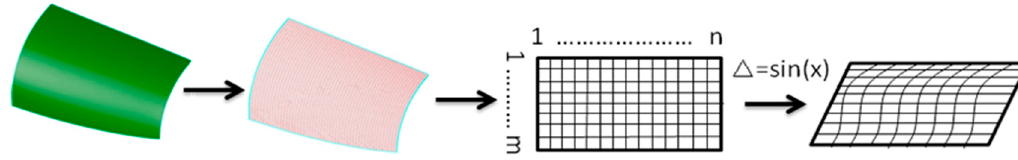
Figure 3. Schematic of surface deformation by Local Shape Function (LSF) method.